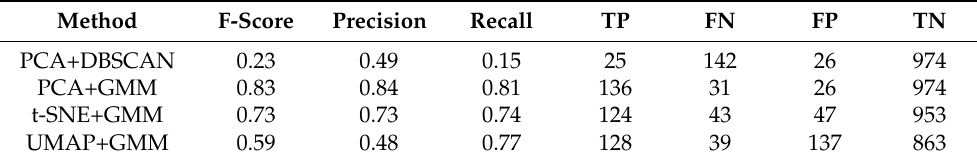
Table 3. Experiment results for Dataset 2a where ANCs are considered as True Anomalies.